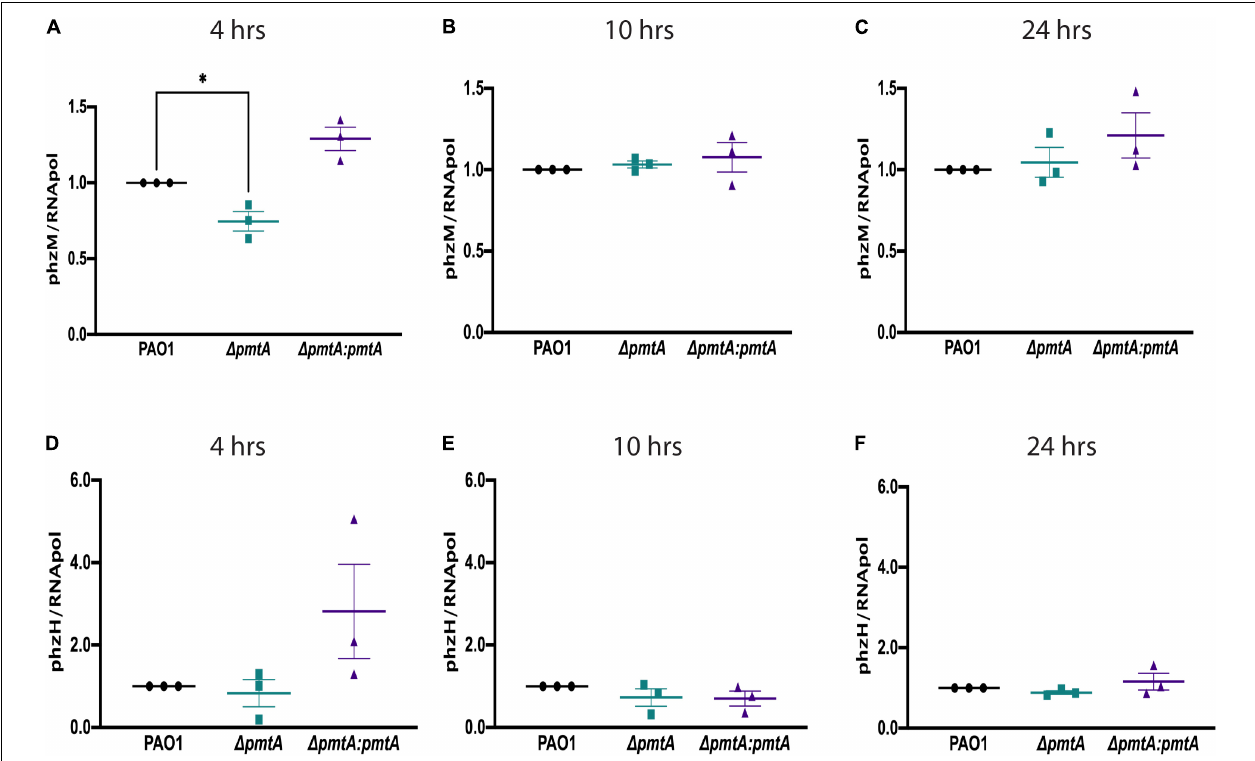
FIGURE 4 | PmtA is required for the early expression of the phenazine pigment precursor 5-methylphenazine-1-carboxylic acid betaine. Overnight cultures of P. aeruginosa strains were grown in LB medium for 4, 10, and 24 h, and total RNA was extracted from the cell pellets. RNA was converted to cDNA using a TaqMan Reverse Transcription kit. qPCR was performed on an ABI7300 instrument using SYBR green fluorescent dye and ROX as a detector. The relative gene expression values for phzM (A–C) and phzH (D–F) were calculated using the cycle threshold value compared to the RNA polymerase, subunit alpha. (A) The expression of phzM at 4 h decreased in the (cid:49) pmtA mutant and was restored in the complemented mutant (cid:49) pmtA : pmtA . CT (cycle threshold) values were used to calculate RQ (relative quantitation) values for phzH and phzM at each time point and normalized to the housekeeping gene RNA polymerase. An unpaired t -test analysis (* p < 0.05, ** p < 0.01, *** p < 0.001, **** p < 0.0001). The data are presented as the average of three biological replicates ( ± standard error of the mean) and are representative of three separate experiments.